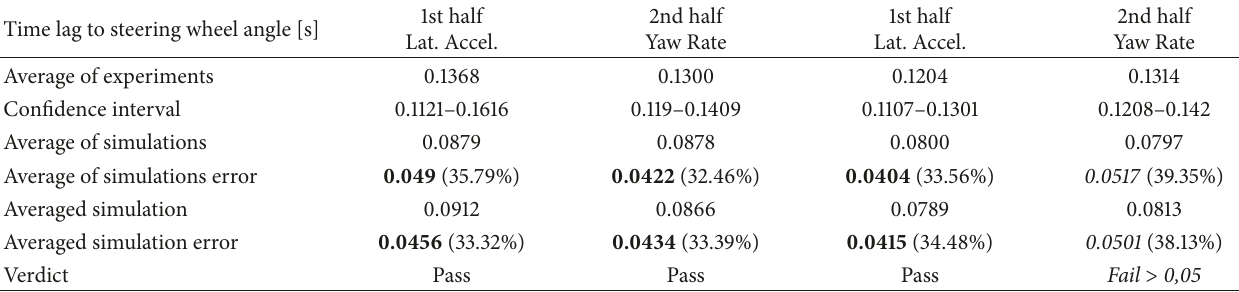
Table 6: Validation results Maneuver Lat-II: time lags.